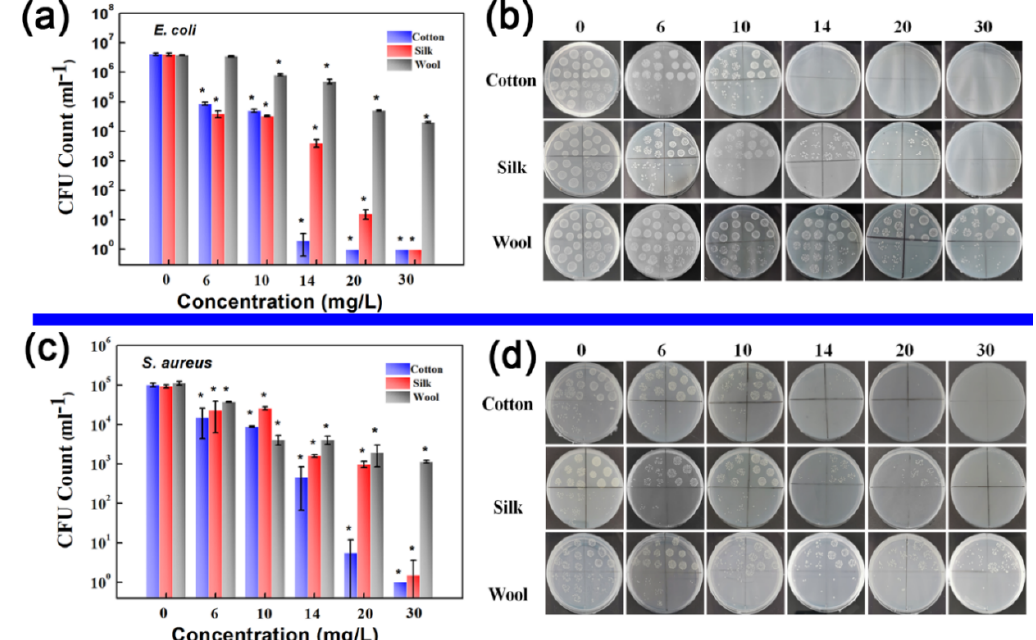
Figure 7. Antibacterial activities of as-prepared Ag, Au, and Pt NP-coated cotton, silk, and wool textiles against E. coli and S. aureus . ( a , c ) CFU content of cotton, silk, and wool textiles after incubation with E. coli and S. aureus for 24 h: the NP mixture concentrations used to treat the textiles were 6, 10, 14, 20, and 30 mg/L. ( b , d ) Corresponding photos of E. coli and S. Aureus colonies in culture dishes (mean ± SD, * p < 0.05).